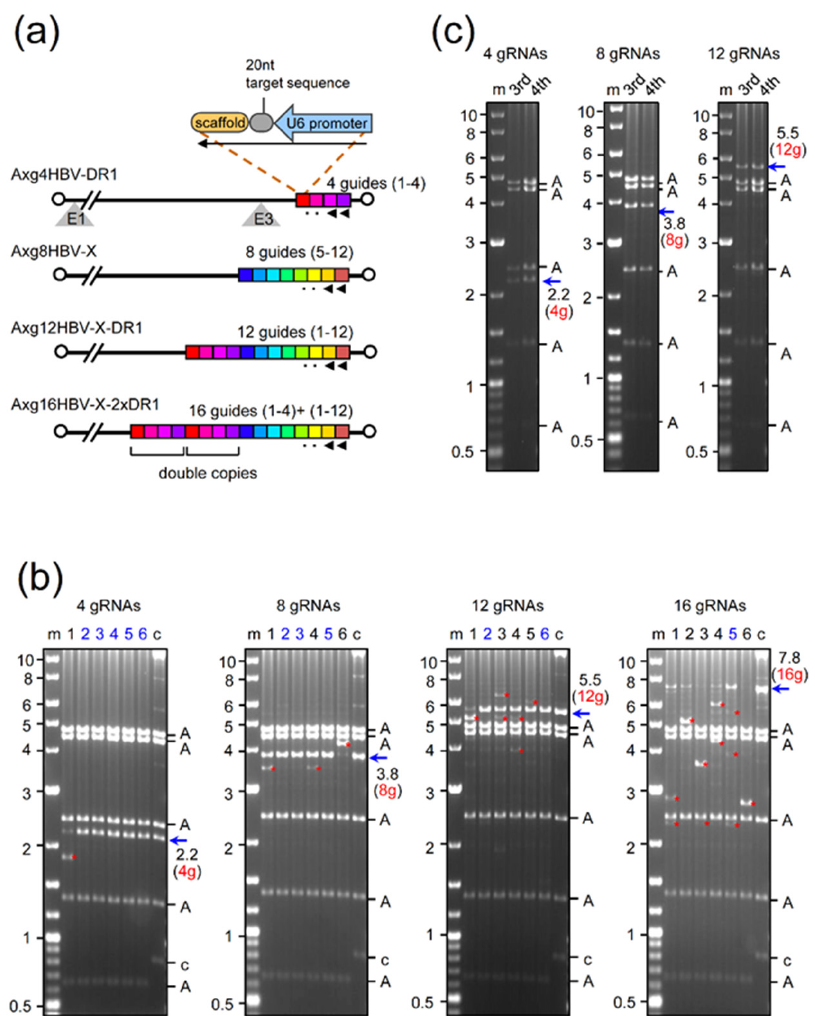
Figure 1. Production of highly multiplex AdVs. ( a ) Structures of AdVs. Each colored box corresponds to one gRNA expression unit. ( b ) The BspEI-cleaved AdV genome of the second viral stock. Lane m, marker; lanes 1–6, clone number; lane c, the parent cosmid containing the AdV genome. A, AdV fragment derived from the parent cosmid identical to the vector backbone; c, the fragment of the cosmid–AdV junction in the cosmid. A blue arrow shows the AdV DNA fragment containing multiplex gRNA units. Asterisk, a band of the DNA fragment containing fewer or more gRNA units. The total cellular DNA of 293 cells infected with AdV of the first stock was digested with BspEI and analyzed by agarose gel electrophoresis. The picture shown as 4 gRNAs originates from Figure 2b of reference [29]. ( c ) The BspEI-cleaved AdV genome derived from infected cells with the third and fourth